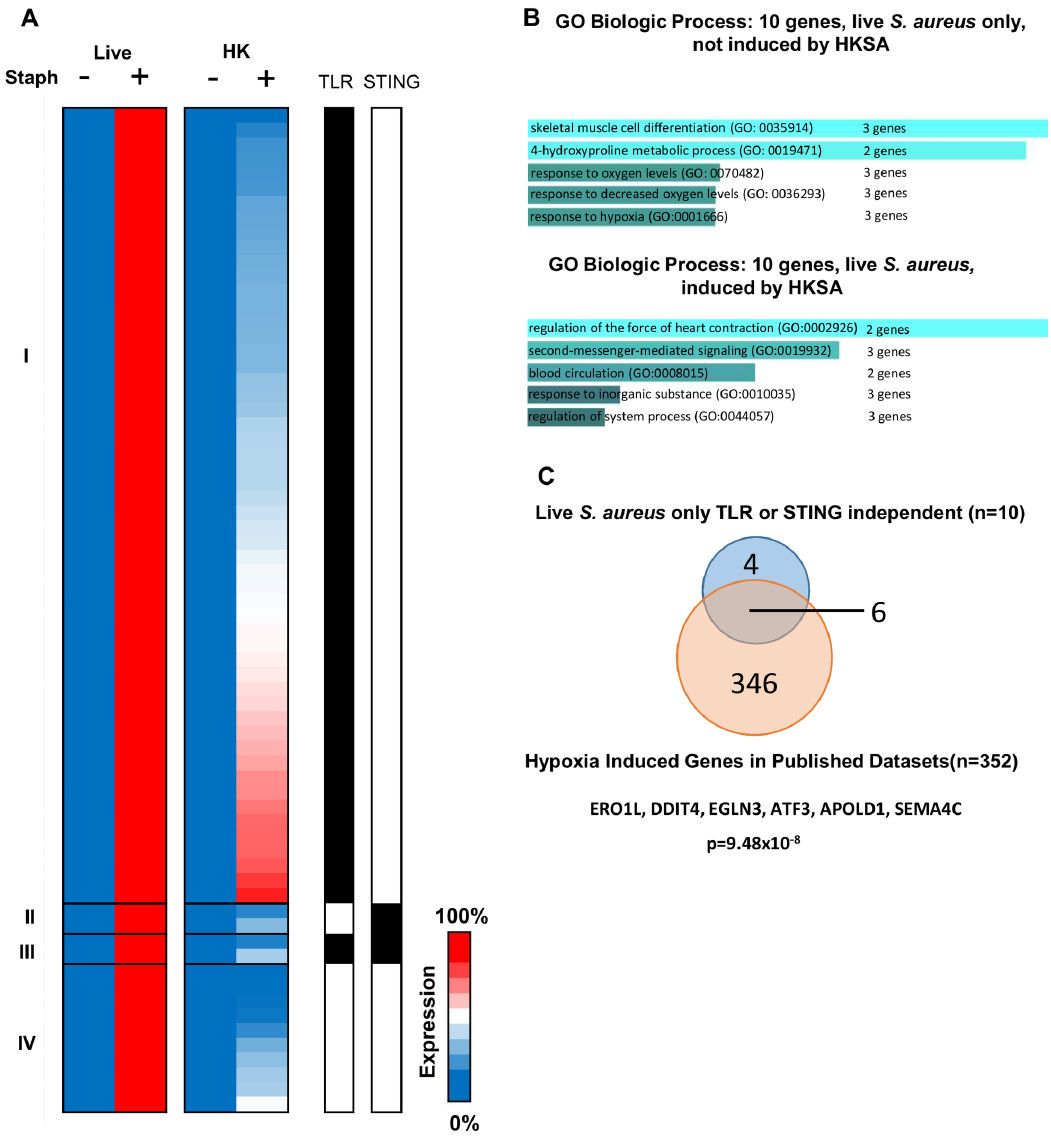
Fig 4. Modes of regulation of a gene signature induced by live S . aureus but not HK S . aureus . (A) Heat map demonstrating 68 genes were inducedby live S . aureus that were not significantly inducedby HK S . aureus (failed RPKM, fold change,or significancecriteria) in BMDMs. TLR signalingwas requiredfor the inductionof the majority of these genes inducedby live S . aureus but not HK S . aureus , with only 2 requiringSTING, and 2 genes requiringboth TLRs and STING. 11 geneswere inducedindependently of MyD88/TRIF or STING signaling in responseto live S . aureus that failed to be inducedby HK S . aureus . (B) GO BiologicProcess of the 20 genes separated by whetherthey were (10 genes) or were not (10 genes)also inducedby HK S . aureus ,reveals genesinducedby live bacteria possess the hypoxiasignature.The numberof genes listed next to the GO Process numberrefers to the numberof S . aureus -induced genes in our dataset that contribute to the significantenrichment of the GO term dataset. (C) Comparisonof the 10 “MyD88/TRIF or STING Independent” cluster of 20 genes that are not inducedby HKSA with known monocyte/macrophagedatasets stimulated with hypoxiareveals significantoverlapof signatures(p-valueby Fisher Exact Test).